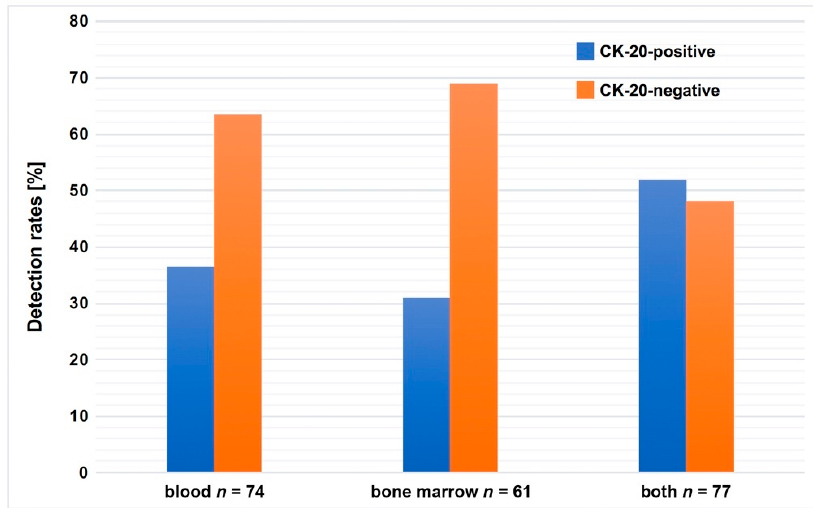
Figure 1. Detection rates of CK20 mRNA in blood or bone marrow or blood and bone marrow of patients with esophageal carcinoma. Blood samples from 74 esophageal cancer (EC) patients and bone marrow samples from 61 EC patients were analyzed for the presence of CK20 mRNA. Data are presented as % detection rate.